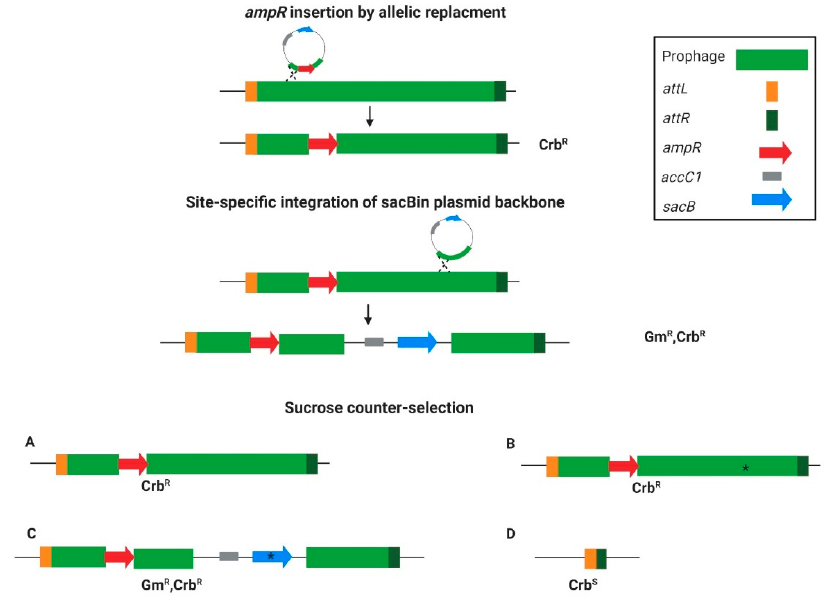
Figure 1. The targeted curing method principle. The prophage is bordered by the right attachment site attR (dark green) and the left attachment site attL (orange). The first step is ampR (red) insertion for prophage tagging. The second step is the integration of the plasmid backbone, containing accC1 (gray) and sacB (light blue) into the prophage region via homologous recombination. Next, the temporal tagged prophage with the integrated sacB undergoes counter-selection by growing on the sucrose-containing growth medium. The counter-selection outcome can be either ( A ) unchanged tagged prophage, ( B ) integration site deletion (marked with an asterisk), ( C ) sacB mutated variant (asterisk), or ( D ) prophage curing. Notably, only option ( D ) would be Crb